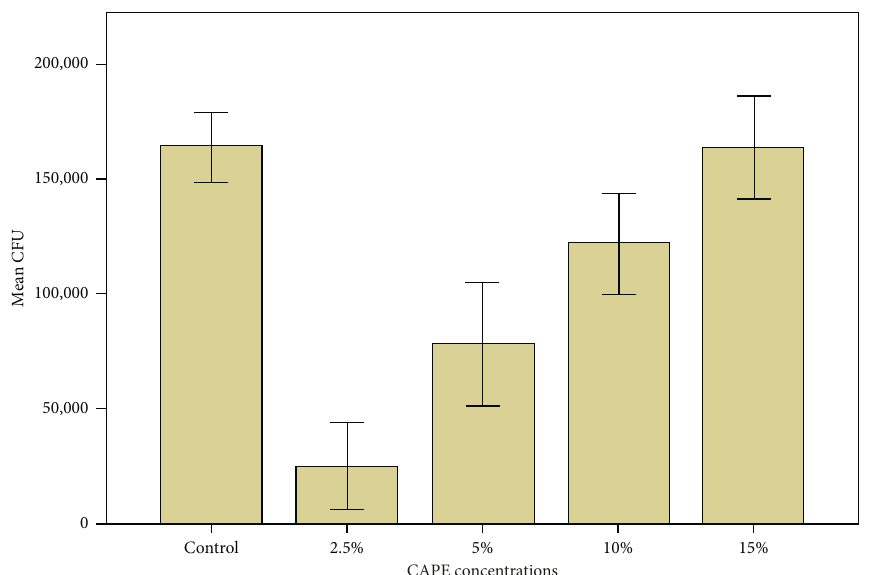
Figure 1: Effect of CAPE concentrations on denture acrylic base presented by mean CFU/mL of C. albicans